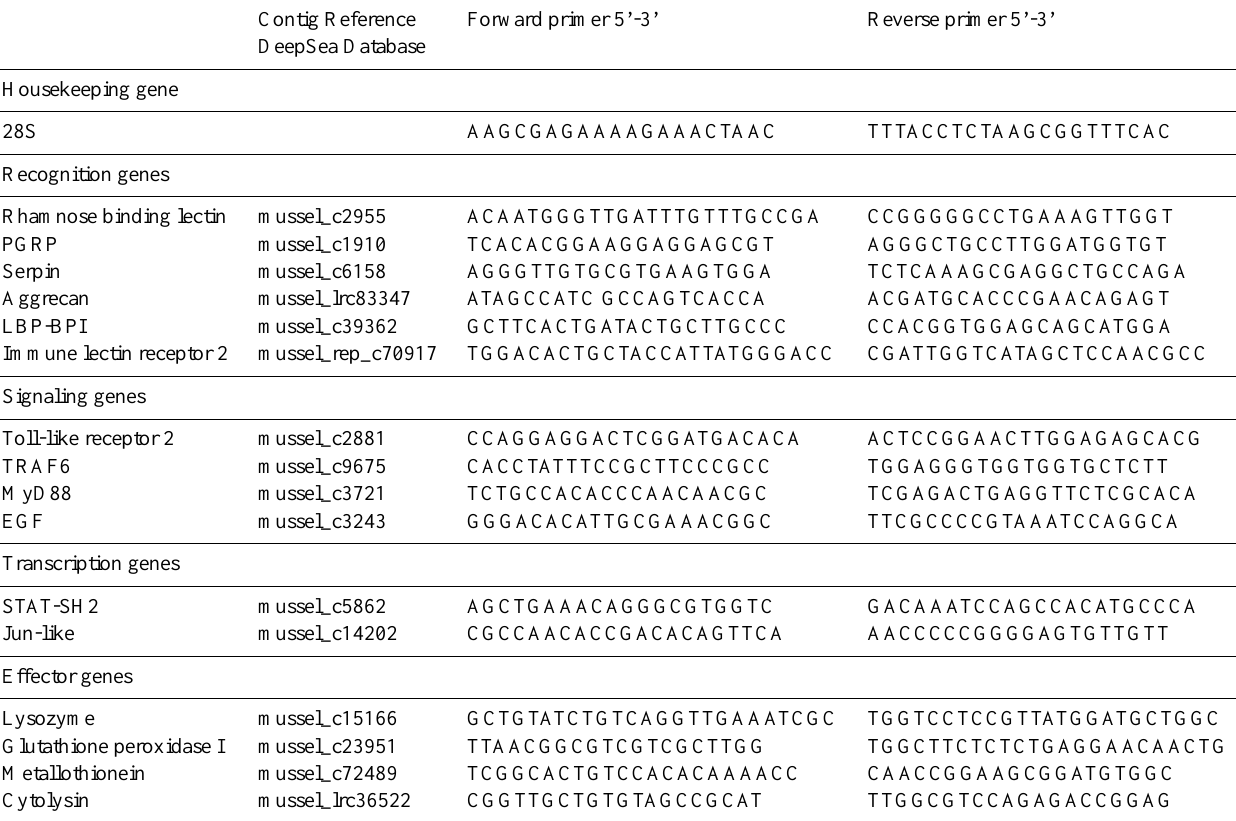
Table 1. Forward and reverse primer sequences of the target Immune response genes according to the immune functional categories, Recog- nition, Signaling, Transcription and Effector genes (Bettencourt et al., 2010), used in qPCR